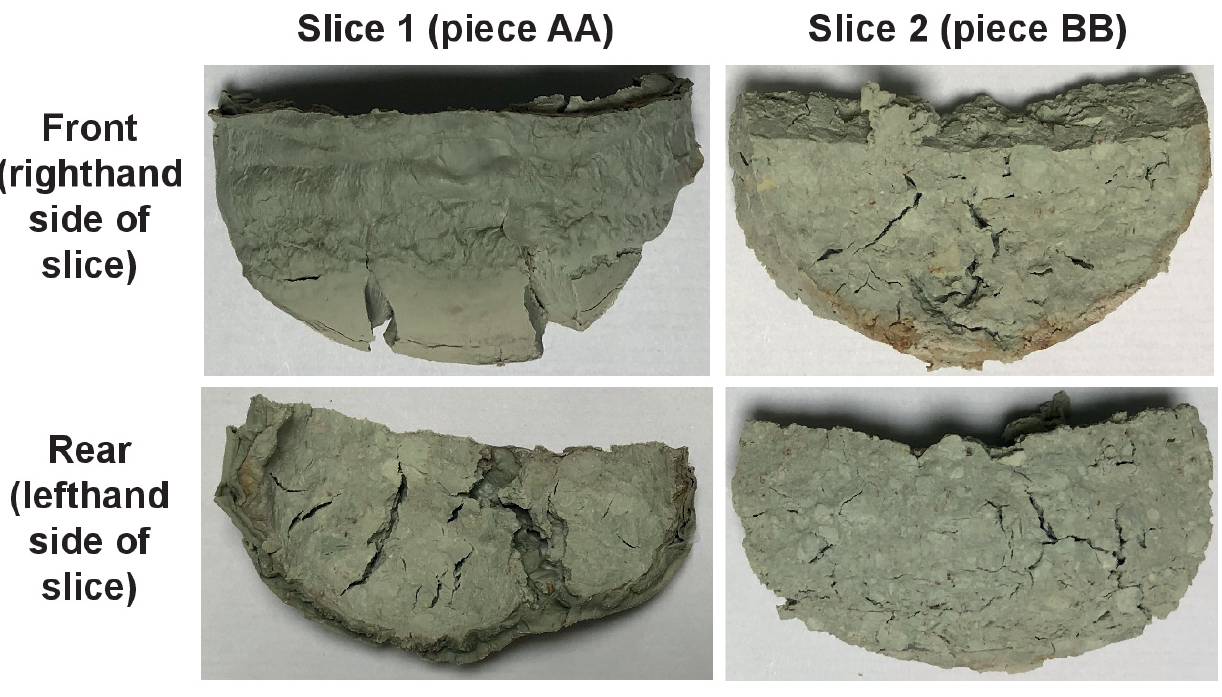
Figure 4. Front and rear views of the dried post-test sample slices 1 (piece AA) and 2 (piece BB) (bottom